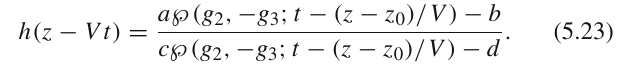
Fig. 2 Plot of the solution (5.23) corresponding to the three real root case. The parameters have the following values: Y = ω 0 = g = 1, λ = V = 0 . 5, χ = 2, κ = 3, z = 0 0